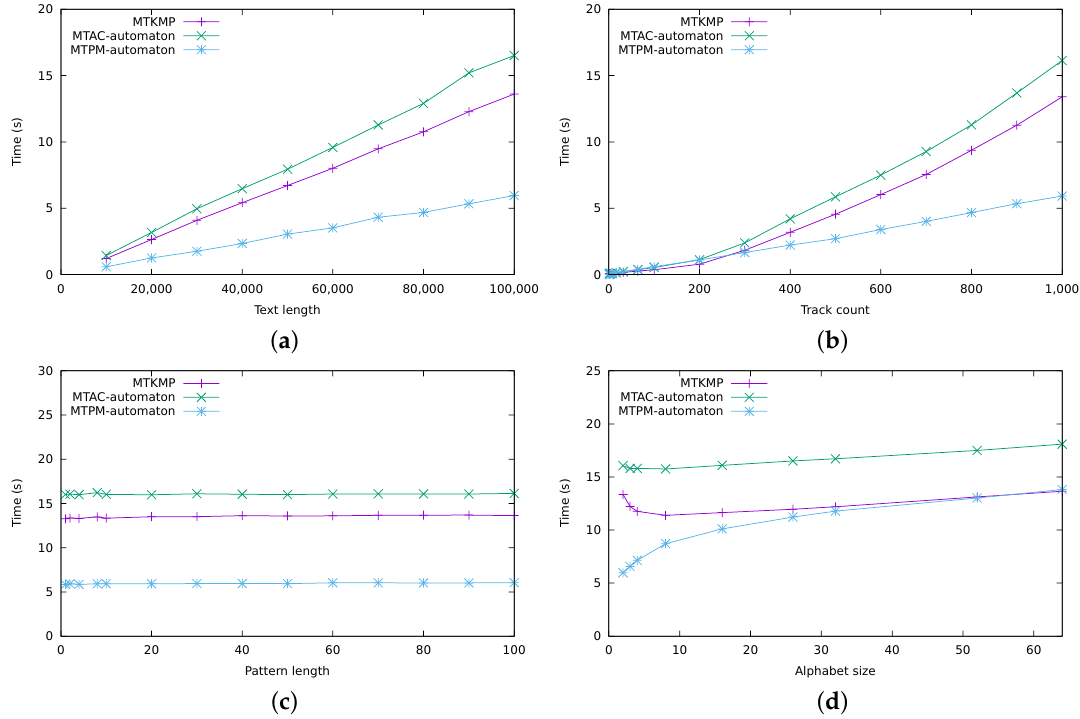
Figure 4. Running time of the multi-track KMP (MTKMP), multi-track AC-automaton (MTACA), multi-track permuted matching automaton (MTPMA) algorithms on permuted pattern matching with respect to ( a ) the text length, ( b ) the track count, ( c ) the pattern length, and ( d ) the alphabet